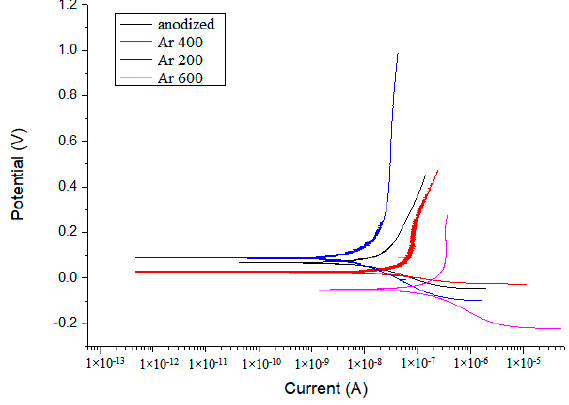
Figure 15. The corrosion behaviors of the annealed samples in Ar gas.